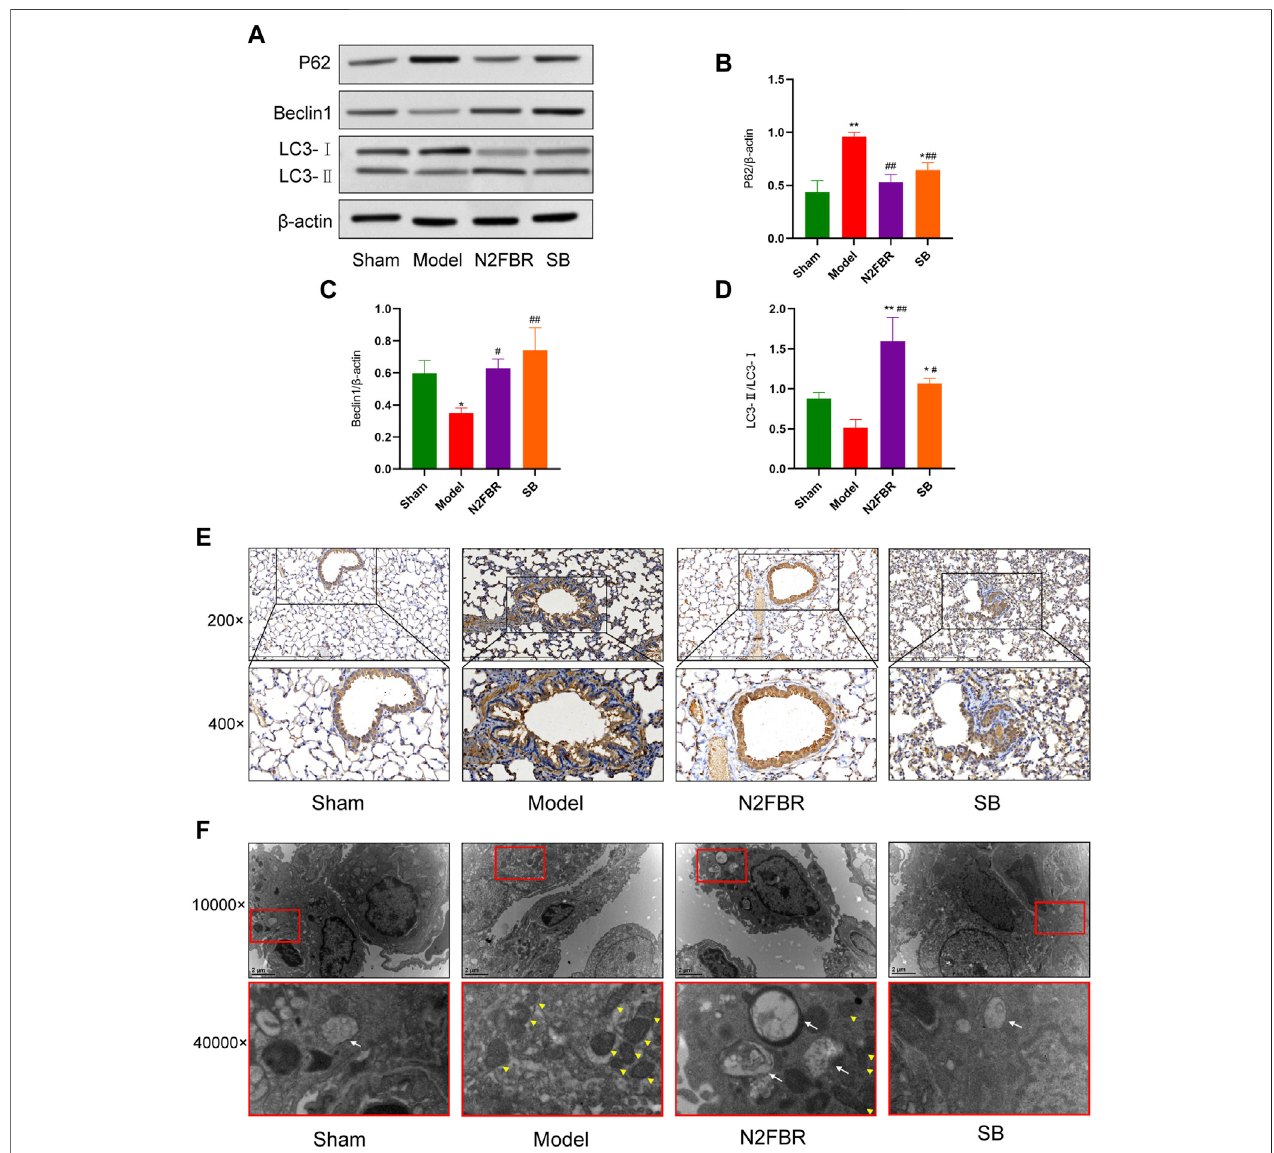
FIGURE5| Effects ofN2FBR onautophagy. (A) Proteinlevels ofbeclin-1,p62, and LC3II asmeasured bywesternblotting. (B – D) Relativedensity valuesshowing P62, beclin1, LC3- II/LC3- I expression. (E,F) Representative images of TEM and immunohistochemical staining for P62. The white arrows indicate autophagosomes and autolysosomes,theyellowarrowheadsindicate abnormalmitochondria.Dataareexpressed as* p < 0.05, ** p < 0.01,comparedwithsham group;# p < 0.05, ## p < 0.01, compared with model group.